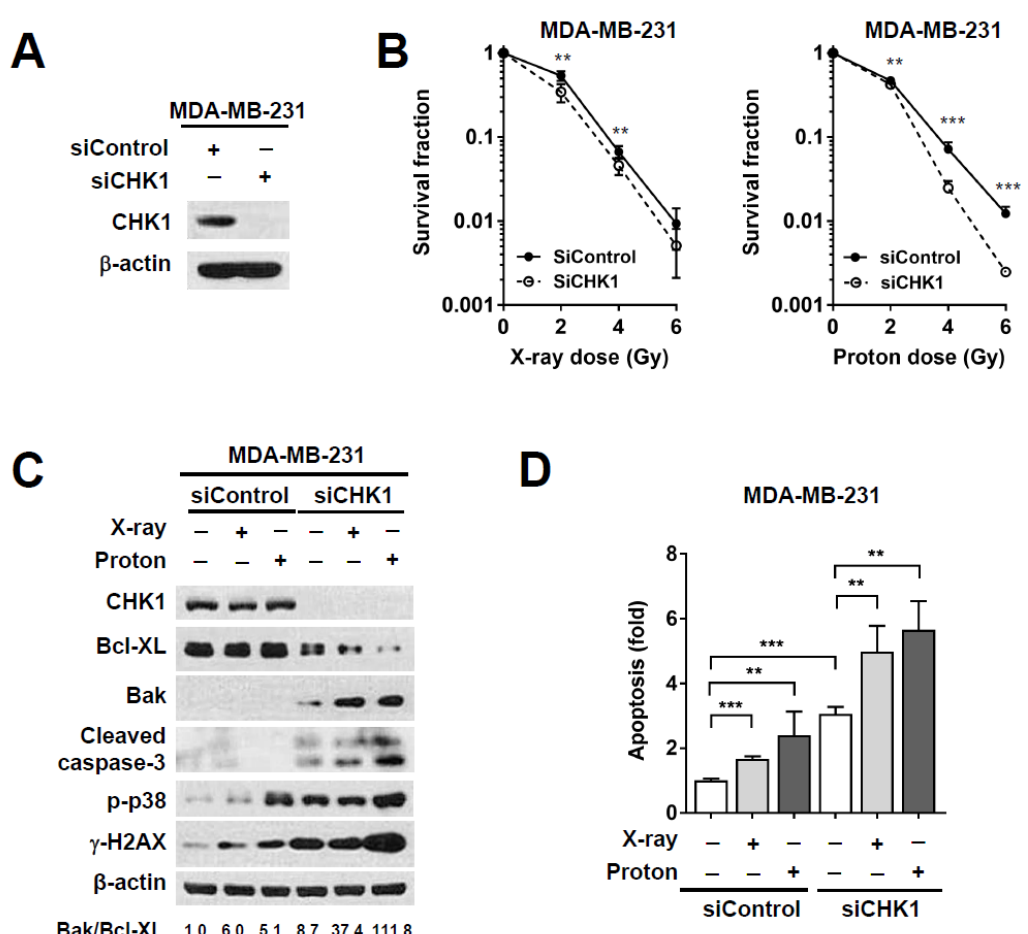
Figure 4. CHK1 silencing using small interfering RNA (siRNA) sensitizes MDA-MB-231 cells to proton irradiation. ( A ) siRNA-mediated CHK1 knockdown was confirmed using western blotting. MDA-MB-231 cells were treated with 10 nM siRNA, and CHK1 levels were determined after 24 h. β -actin was used as loading control; ( B ) The clonogenic survival assay showed that siRNA-mediated CHK1 knockdown resulted in enhanced proton radiosensitivity of MDA-MB-231 cells. Data are shown as mean ± S.D. from two independent experiments. ** p < 0.01; *** p < 0.001; ( C ) Western blot showed that CHK1 knockdown using siRNA further increased the radiation-induced pro-apoptotic signaling. Cells were treated with 10 nM siRNA for 24 h, followed by irradiation with 4 Gy of X-rays or protons. Cells were harvested 72 h post-irradiation. β -actin was used as a loading control. Densitometric analysis showed increased Bak / Bcl-XL ratio after co-treatment with CHK1 siRNA and protons; ( D ) Flow cytometric analysis revealed that apoptosis was enhanced in response to combinatorial treatment with CHK1 siRNA and 4 Gy of proton irradiation. Data are shown as mean ± S.D. from two independent experiments. ** p < 0.01; *** p < 0.001.